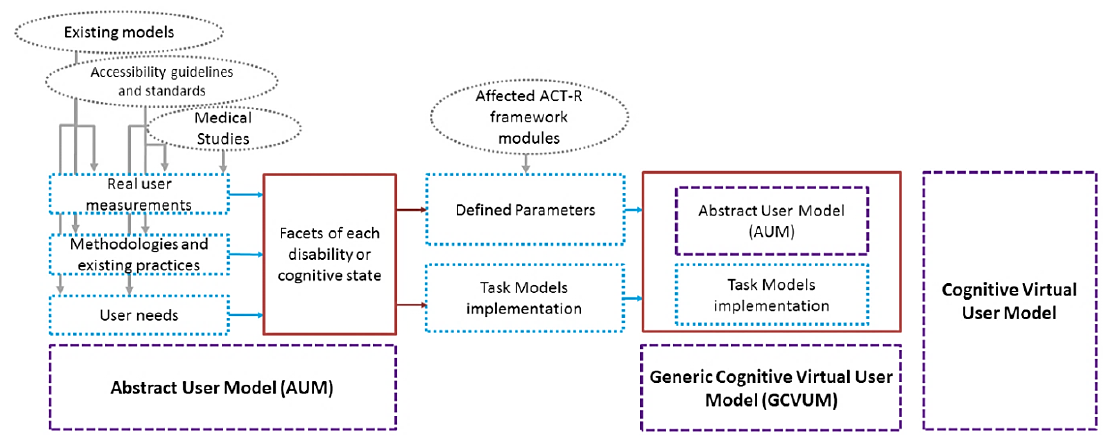
Figure 1. Overview of the process to create the Cognitive Virtual User Model.